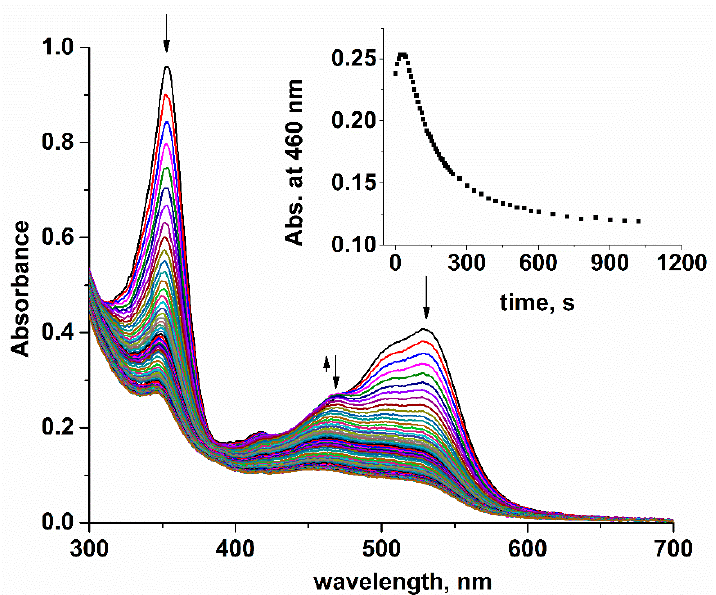
Figure 3. UV-vis spectra of the reaction between H 2 OCbl (5.0 · 10 − 5 M) and HSO 5 − (1.0 · 10 − 3 M) at pH 7.4, 25.0 °C. Time intervals between the spectra are 10, 30, and 60 s for 0–4, 4.5–10 and 10–17 min of the reaction, respectively. Maxima at 353, 505, and 528 nm correspond to H 2 OCbl, and maximum at ca. 470 nm—the product of H 2 OCbl modification by HSO 5 − (dioxo-secocorrinoid). Inset: a time-course curve of the reaction.